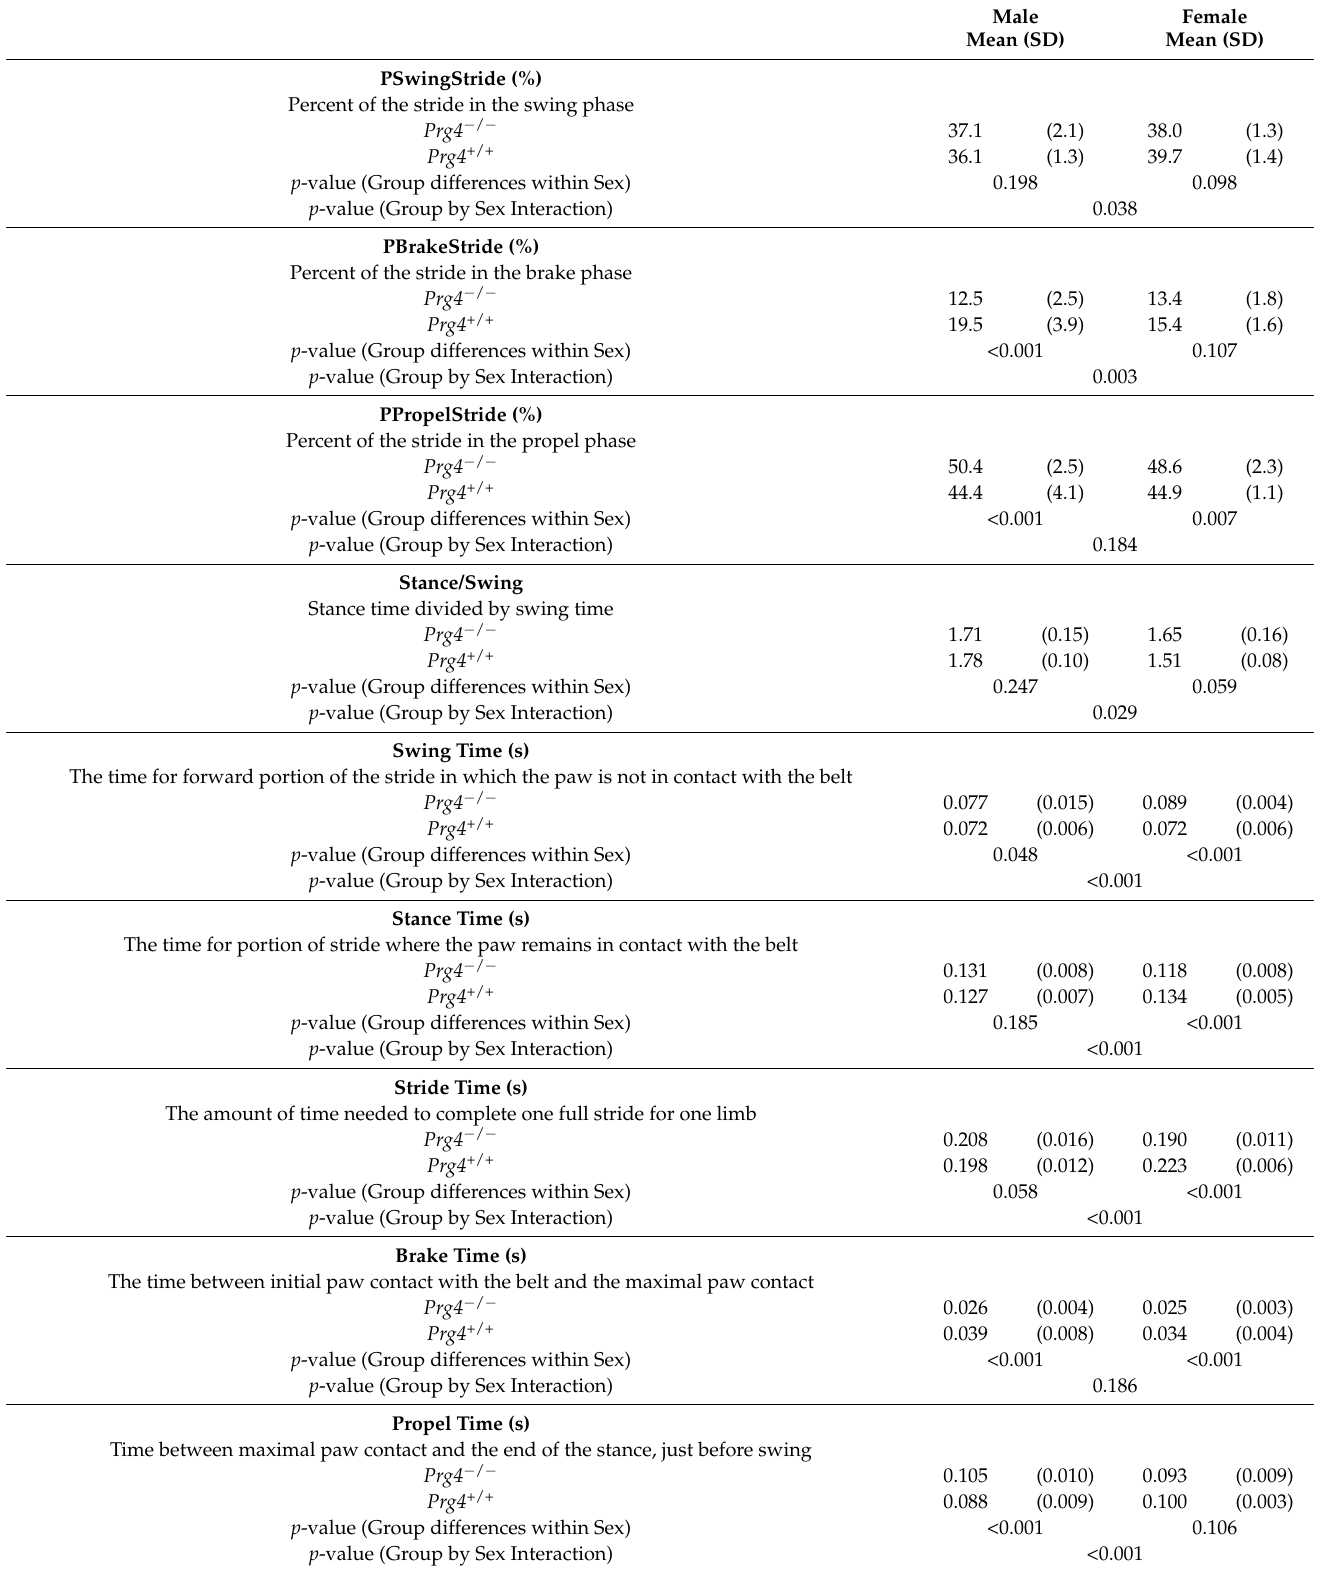
Table 1. Difference in hindlimb gait between Prg4 − / − and Prg4 +/+ mice by